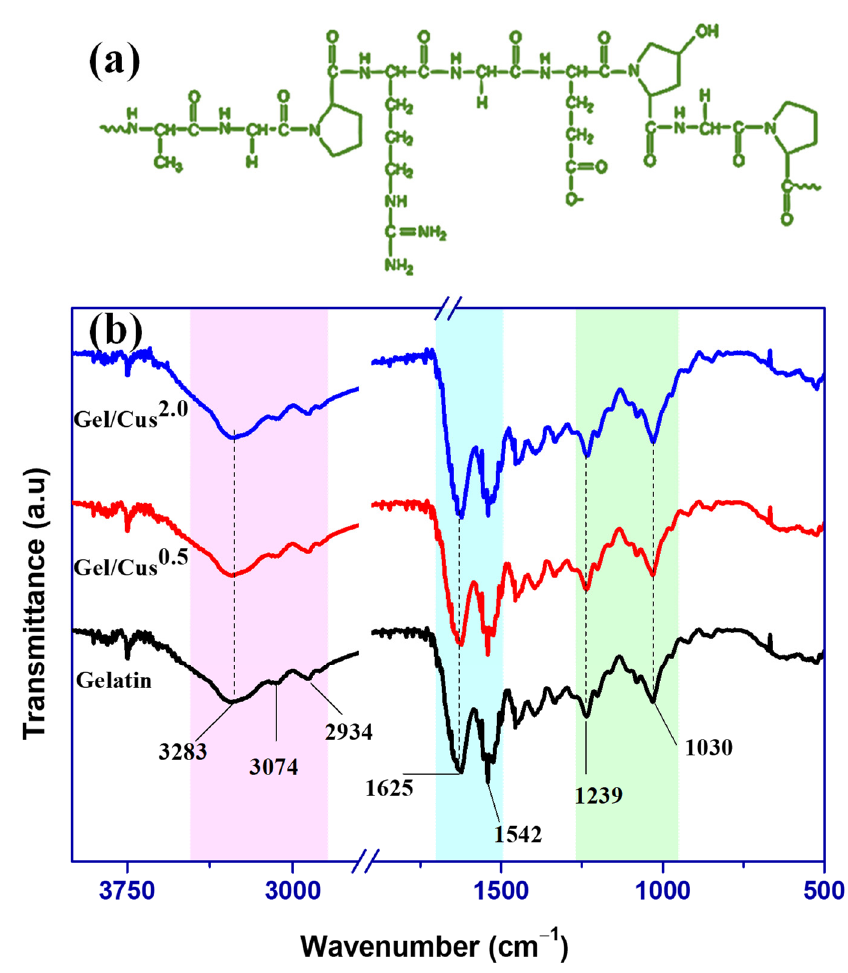
Figure 4. Structure of gelatin ( a ) and FTIR spectra ( b ) of Gel/CuSNP films. Table 3. Mechanical properties, hydrophobicity, and water vapor permeability of control and gelatin/CuSNP films. Films Thickness ( µ m) Gelatin Gel/CuS 0.5 Gel/CuS 1.0 Gel/CuS